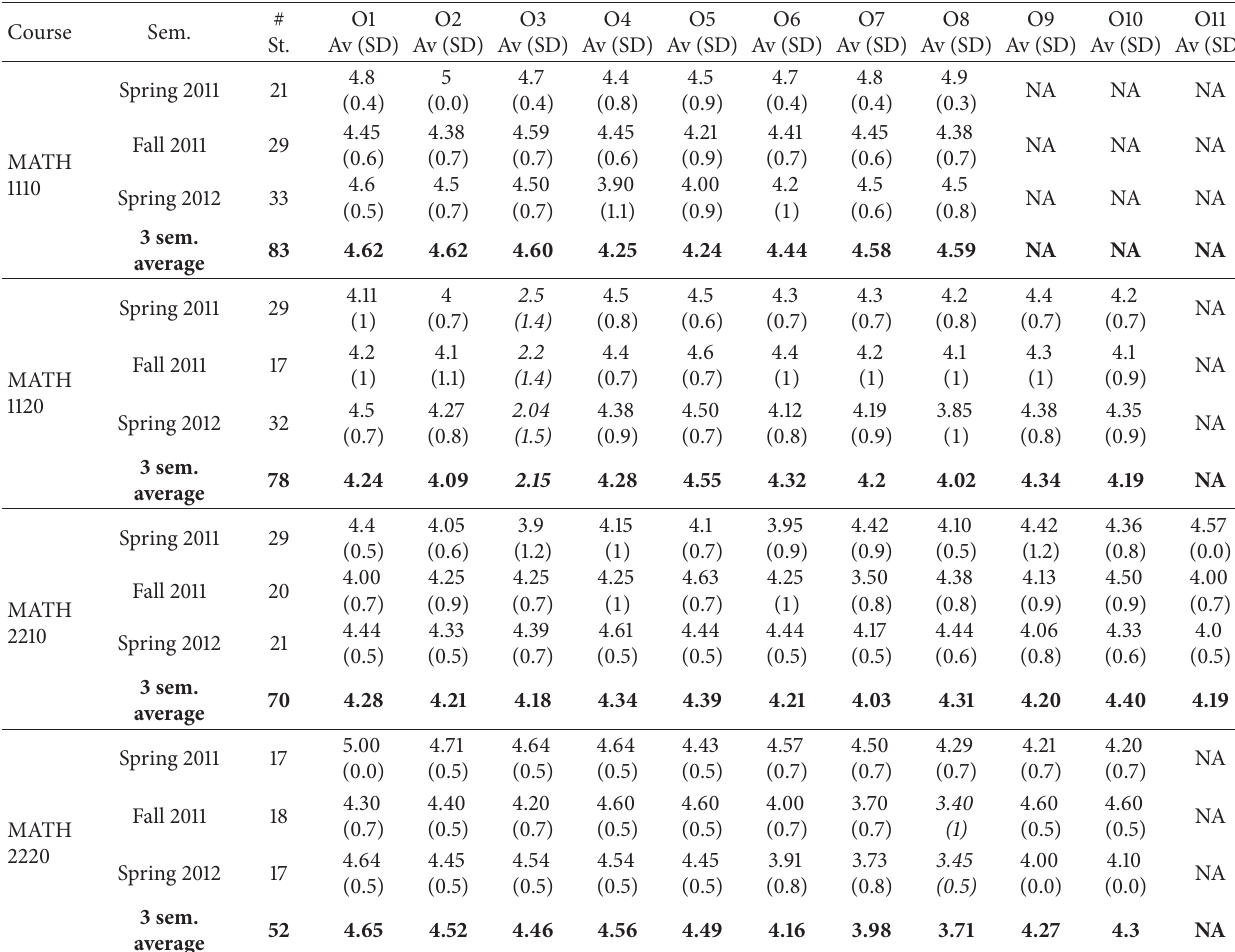
Table 8: Opinion assessment of course outcomes based on indirect measures “students survey” (NA: not applicable, Values in italic are below the outcomes-achievement passing